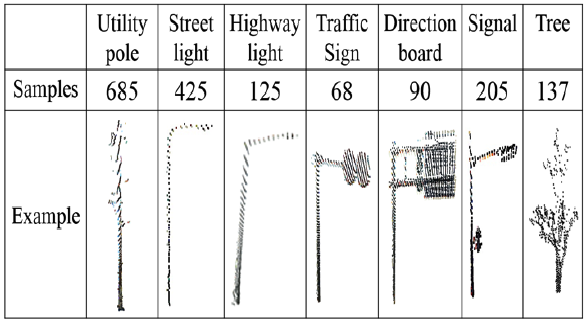
Figure 18. Pole-like objects used in experiments